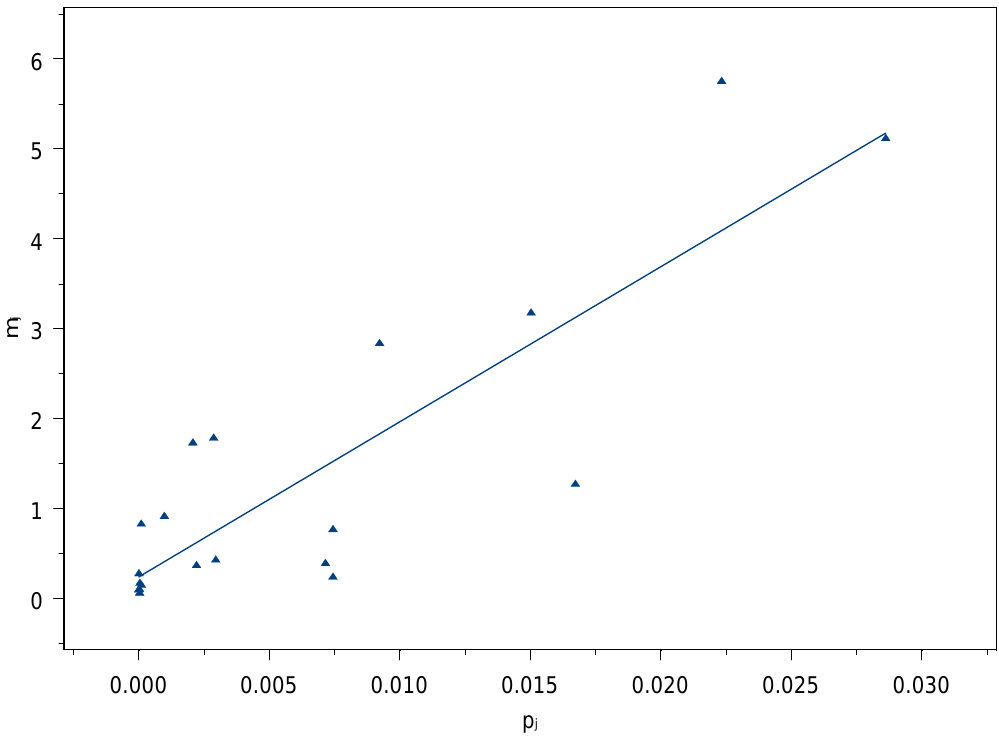
Figure 2. Regression model with the 20 selected subpopulations of known size chosen for the final estimates.